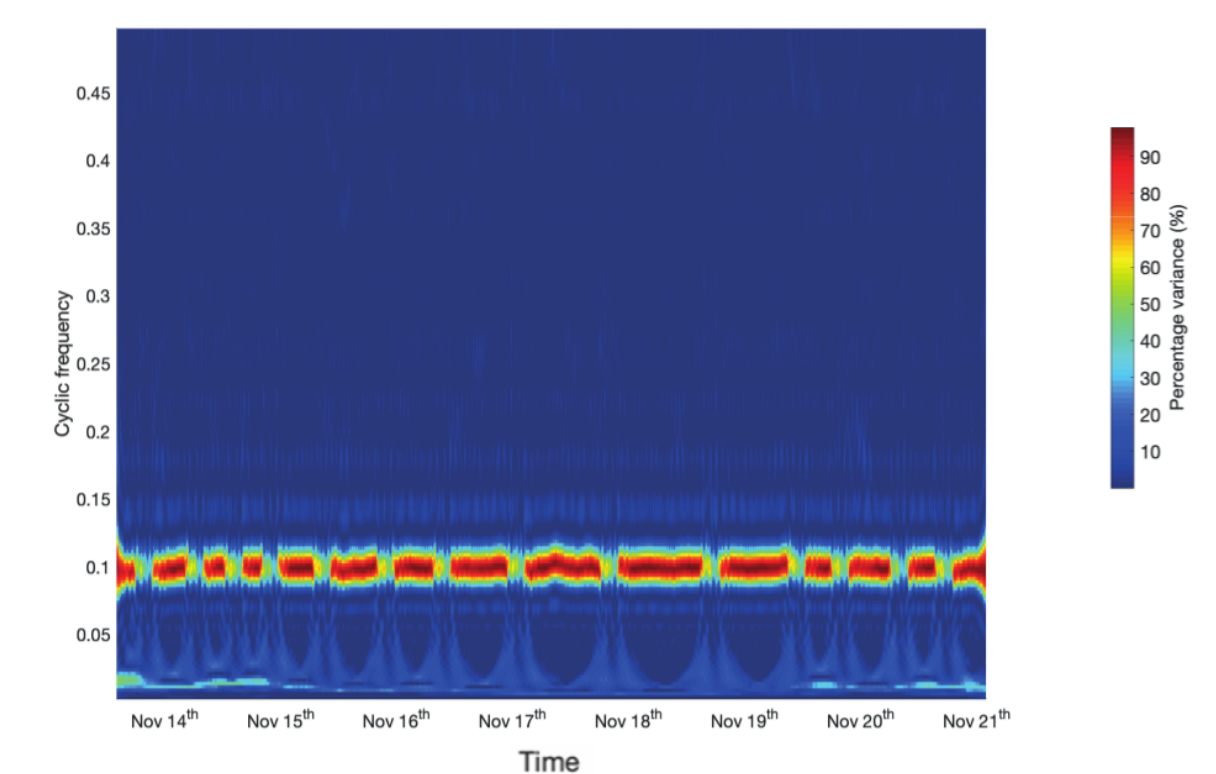
Figure 9. Least-squares wavelet analysis (LSWA) applied to the training set of electricity consumption.